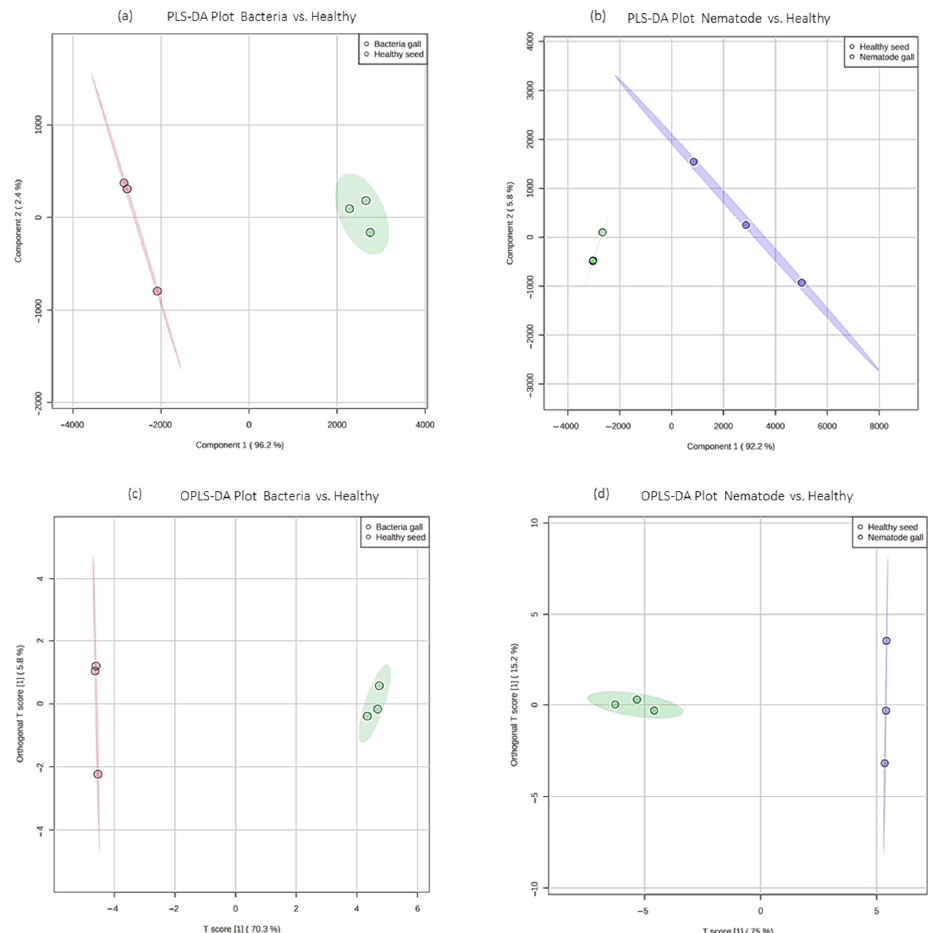
Figure 5. Partial least squares-discriminant analysis (PLS-DA) and orthogonal PLS-DA (OPLS-DA) score plots of ryegrass samples. ( a , b ) PLS-DA score plots for bacteria gall versus healthy seed and nematode gall versus healthy seed, respectively; ( c , d ) OPLS-DA score plots for bacteria gall versus healthy seed and nematode gall versus healthy seed, respectively. Red represents bacterial group, blue represents nematode group, and green represents healthy seeds.